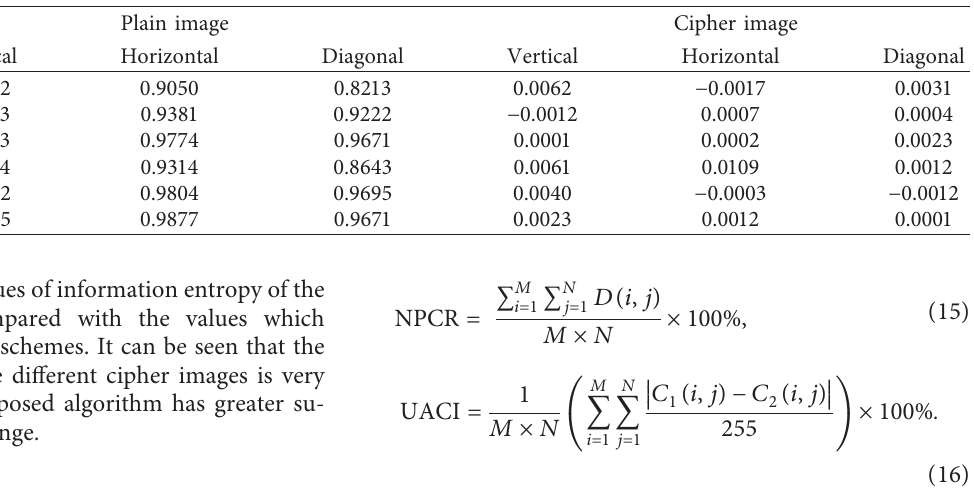
Table 5: Correlation coefficients